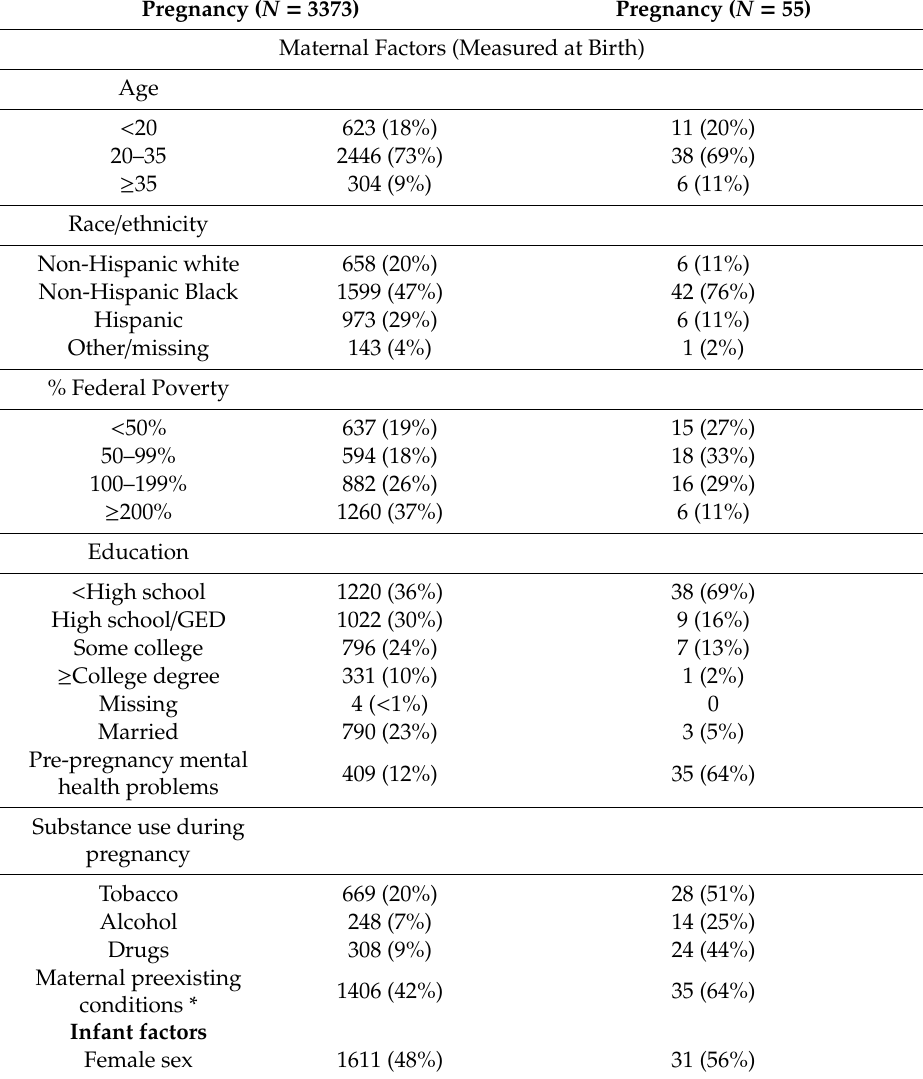
Table 1. Characteristics of mothers and infants who did vs. did not experience housing